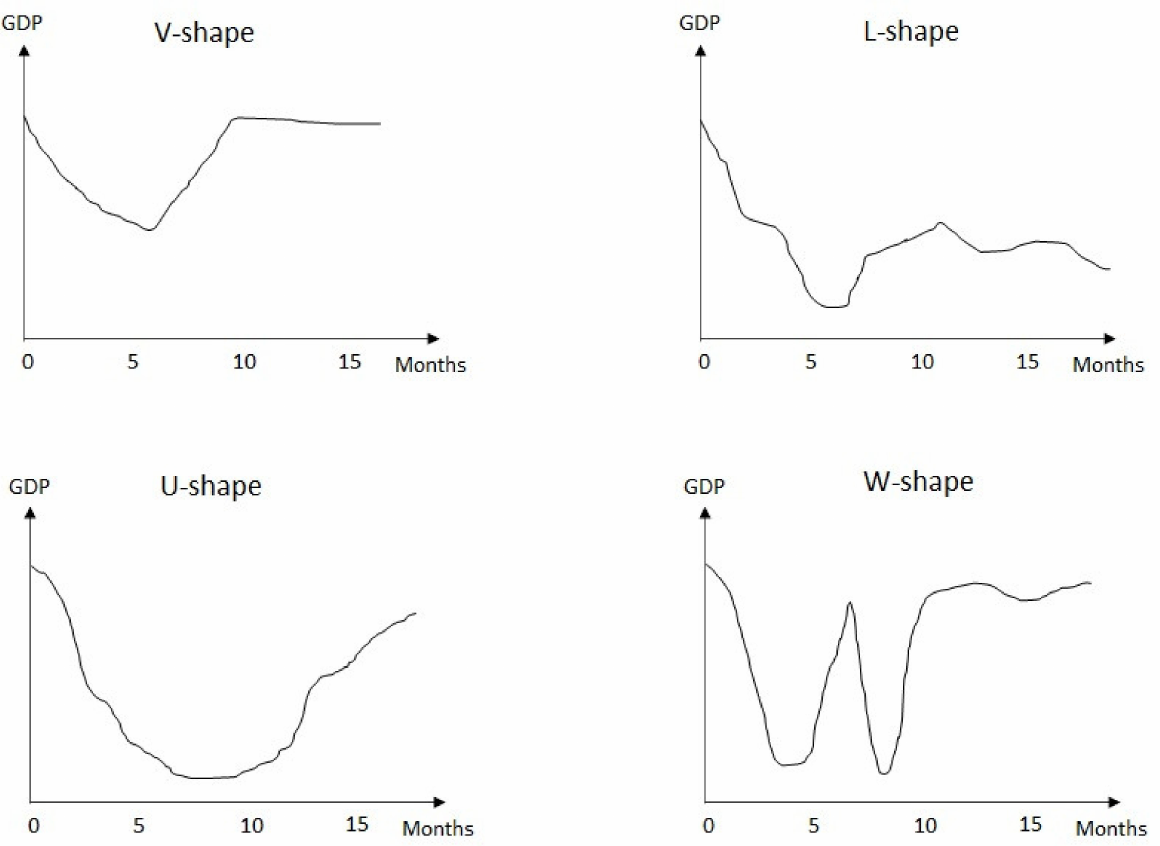
Figure 1. The trends of economic recession and recovery